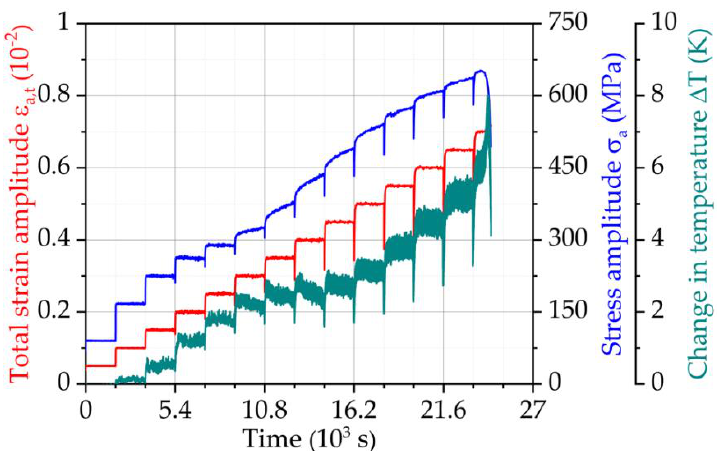
Figure 6. Change in temperature ΔT results of one SIT at RT.